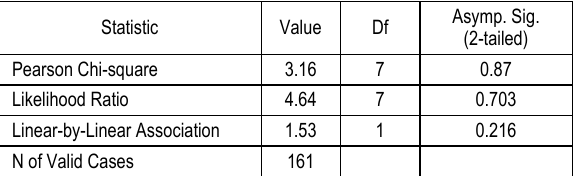
Table 12. Operating sector versus risk perception